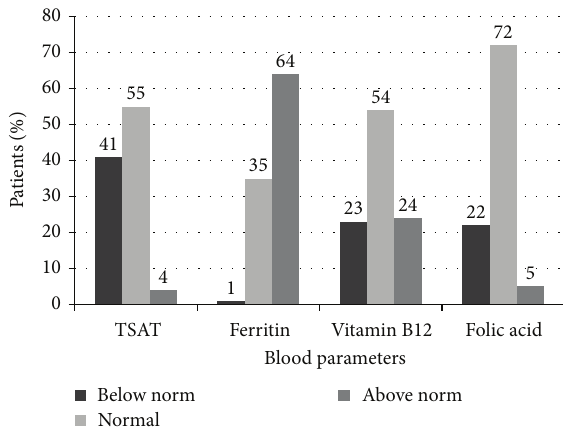
Figure 1: Anemia-related laboratory parameters at time of admis- sion (TSAT = transferrin